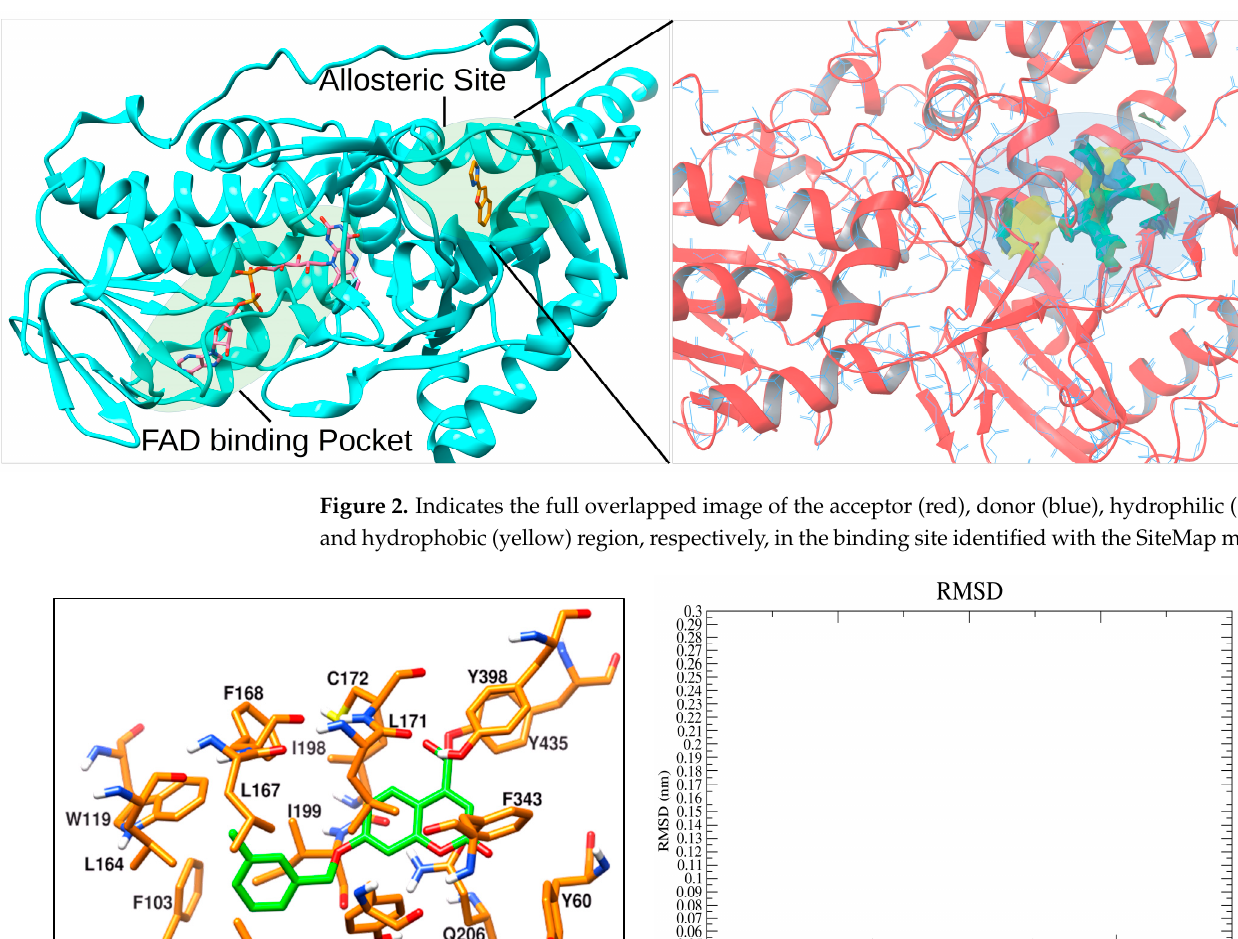
Figure 2. Indicates the full overlapped image of the acceptor (red), donor (blue), hydrophilic (green), and hydrophobic (yellow) region, respectively, in the binding site identi fi ed with the SiteMap module.